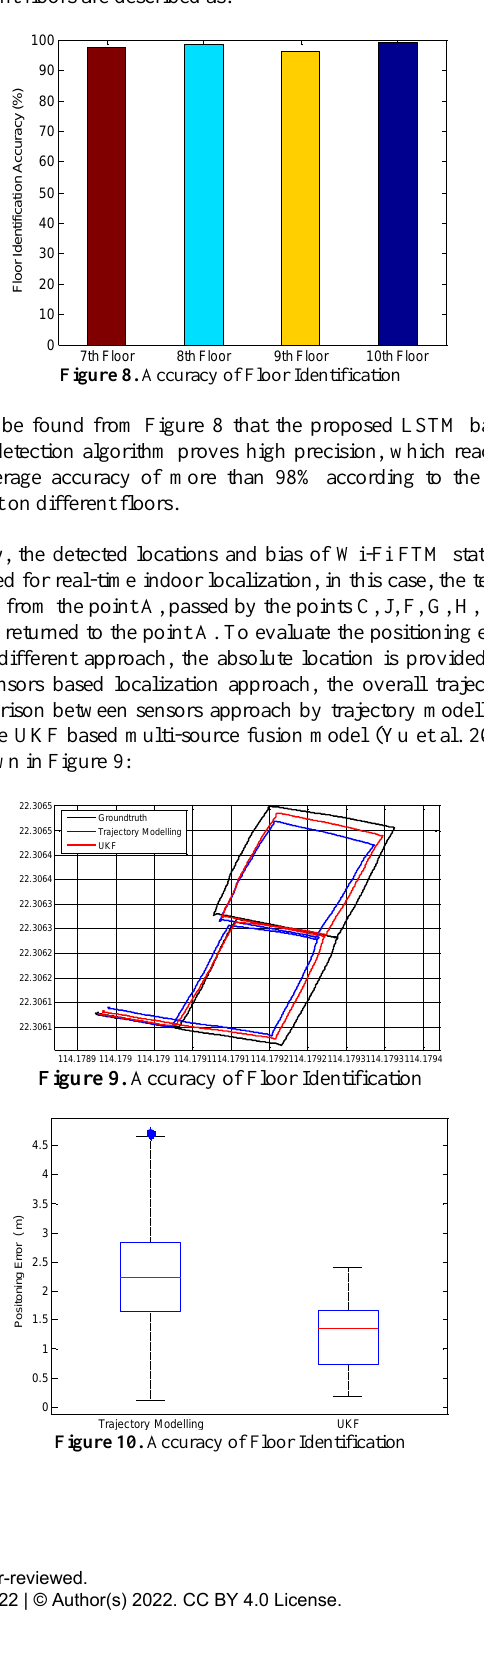
Figure 10. Accuracy of Floor